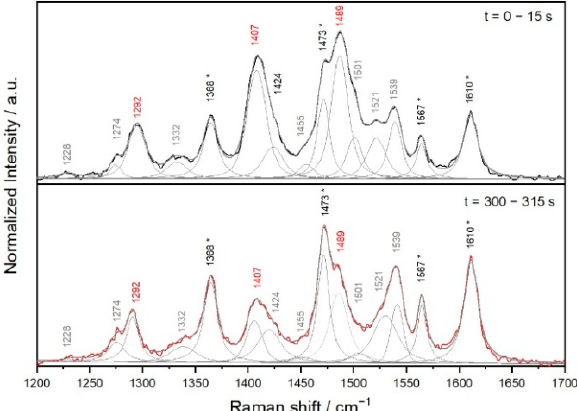
Figure 6. Deconvolution of the first and last RRS of FeET ( λ exc = 532 nm; 0.1 mW).